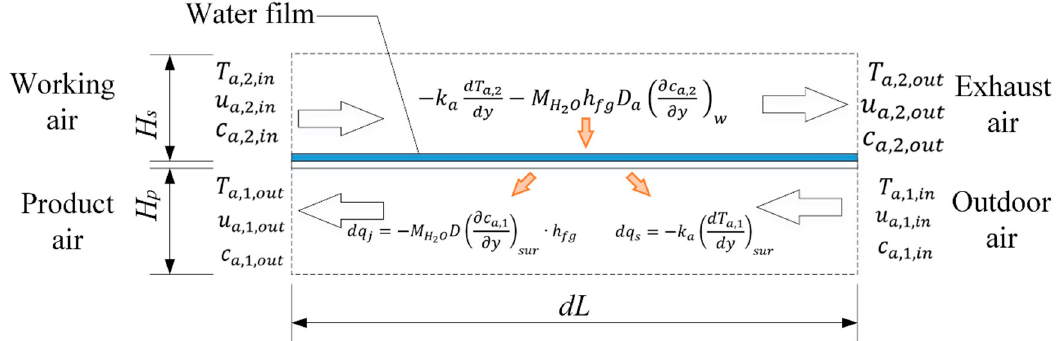
Figure 2. Description of the calculation element of the pre-cooling IEC.